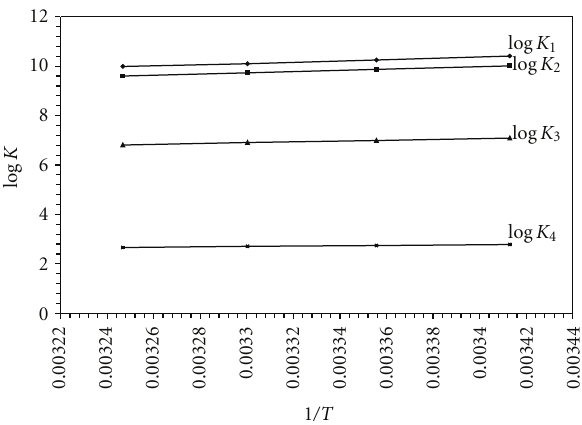
Figure 4: E ff ect of temperature on stepwise protonation constant of H 4 BAPP +4 . Curves: log K 1 corresponds to the 011 species; log K 2 corresponds to 012 species; log K 3 corresponds to 013 species; log K 4 corresponds to 014 species.